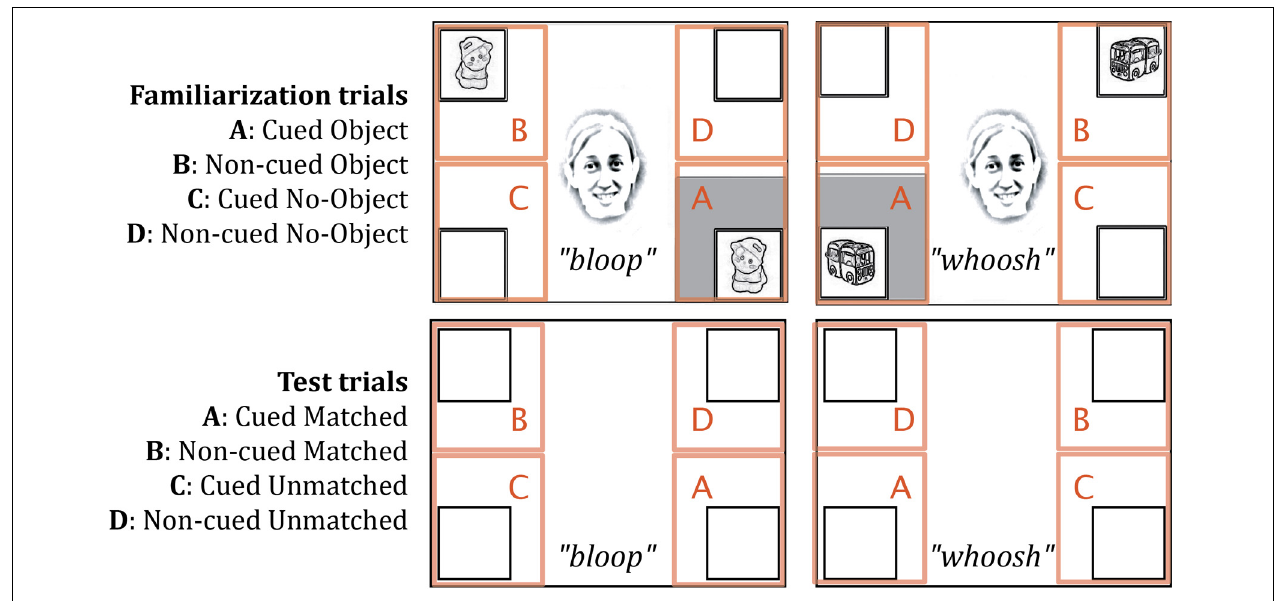
FIGURE 2 | Areas of interest (AOIs) delineated for familiarization and test trials. The four AOIs were identical in